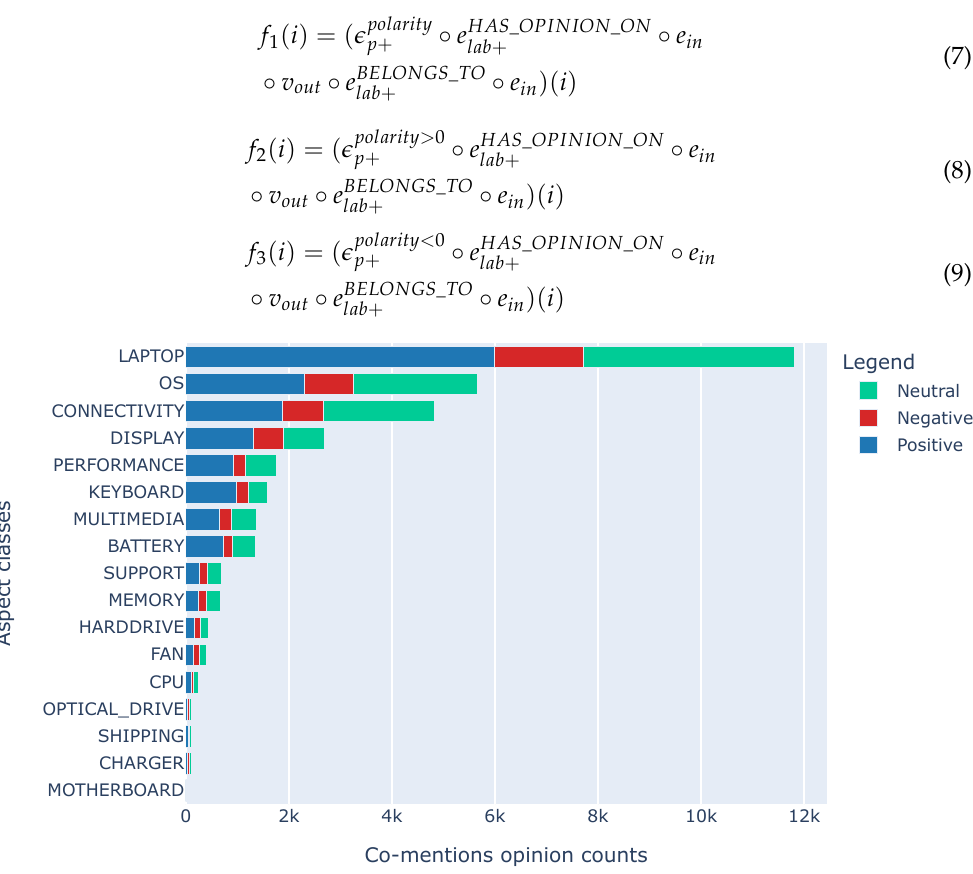
Figure 7. Distribution of customer opinion interest intensity on the aspect